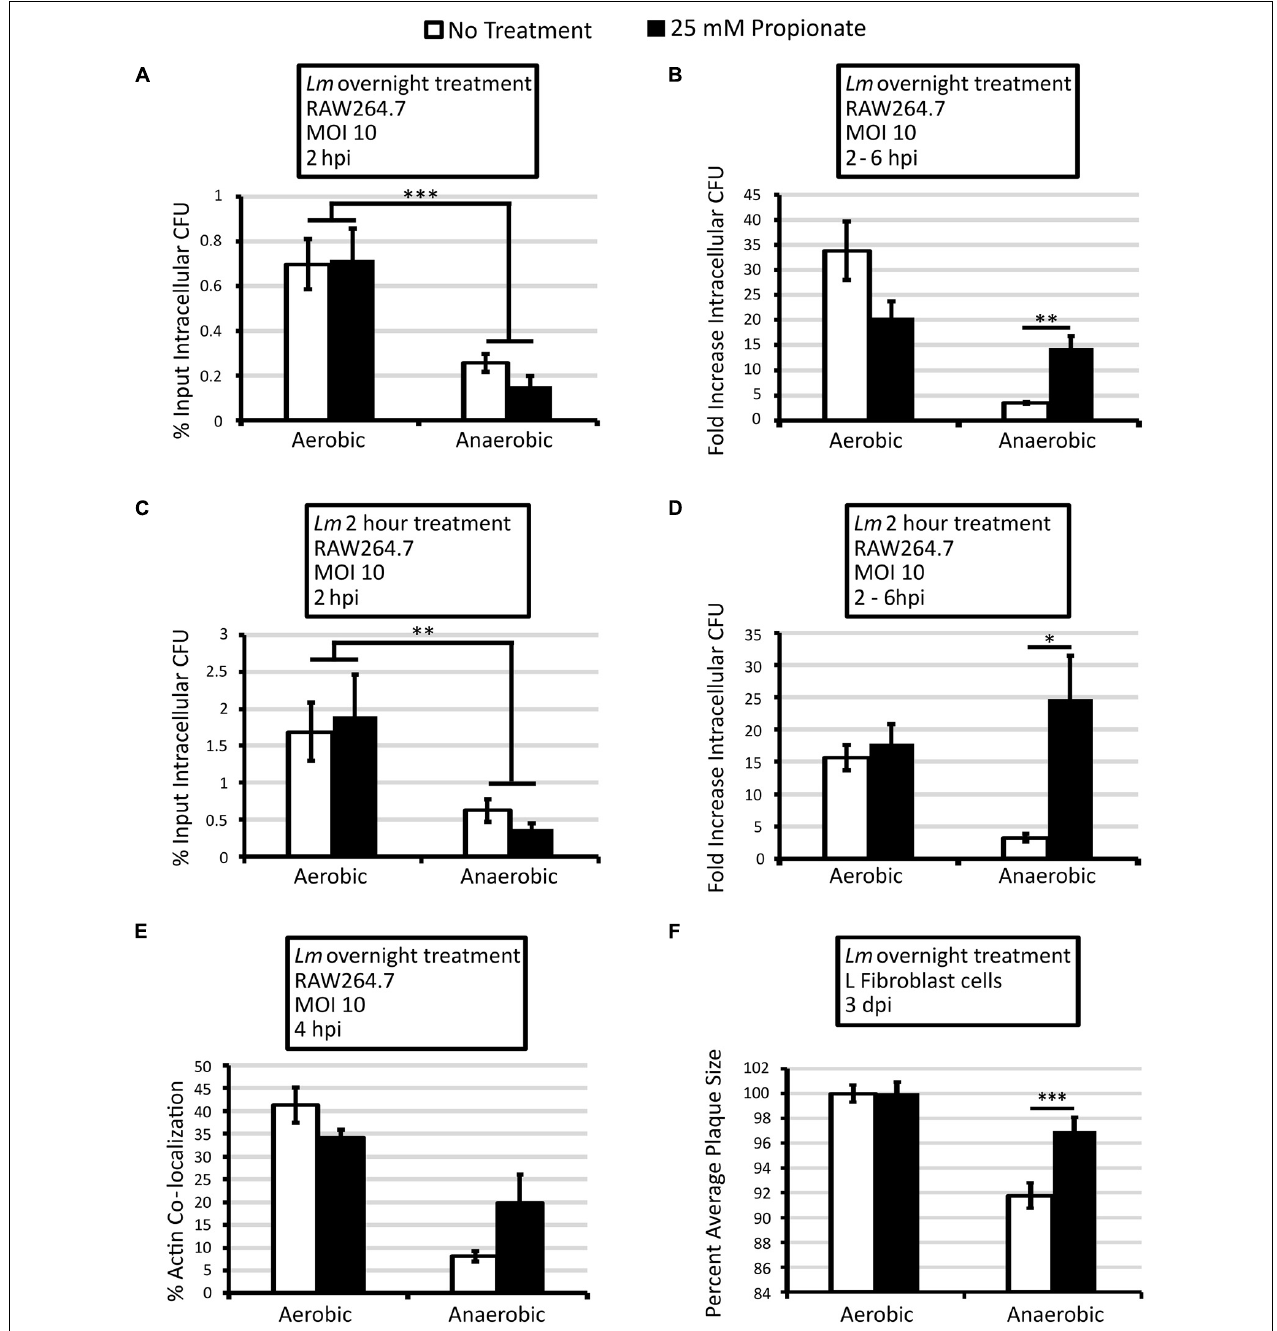
FIGURE 1 | Pretreatment of anaerobic L. monocytogenes with 25 mM propionate enhances intracellular growth and cell-to-cell spread. L. monocytogenes strain 10403s was grown aerobically or anaerobically with (black bars) or without (white bars) 25 mM propionate for overnight (A,B,E,F) or for 2 h (C,D) and rinsed to remove all residual propionate from culture media prior to infections. Infected RAW64.7 macrophages were lysed at 2 and 6 hpi to enumerate intracellular CFU. Percent input intracellular CFU (A,C) was calculated by comparing intracellular CFU at 2 hpi to CFU in the infection inoculum while fold increase intracellular CFU (B,D) was calculated by comparing intracellular CFU between 2 and 6 hpi. Averages from 3 independent experiments, each performed in triplicate, were plotted with error bars representing standard errors of the mean (A–D) . (E) Immunofluorescence microscopy was performed at 4 hpi where filamentous actin and L. monocytogenes were differentially stained and quantified for co-localization. A minimum of 200 L. monocytogenes cells were counted from each replicate and condition over 3 independent experiments performed in duplicate. Averages were plotted with error bars representing standard errors of the mean. (F) Plaque diameters of infected L fibroblasts were measured at 3 dpi and those from aerobically grown L. monocytogenes without propionate were used as controls. Averages of a minimum of 80 plaques for each condition over 4 independent experiments were plotted with error bars representing standard errors of the mean. Asterisks denote statistical significance between propionate treated and control groups with ∗ p < 0.05, ∗∗ p < 0.01, and ∗∗∗ p < 0.001.